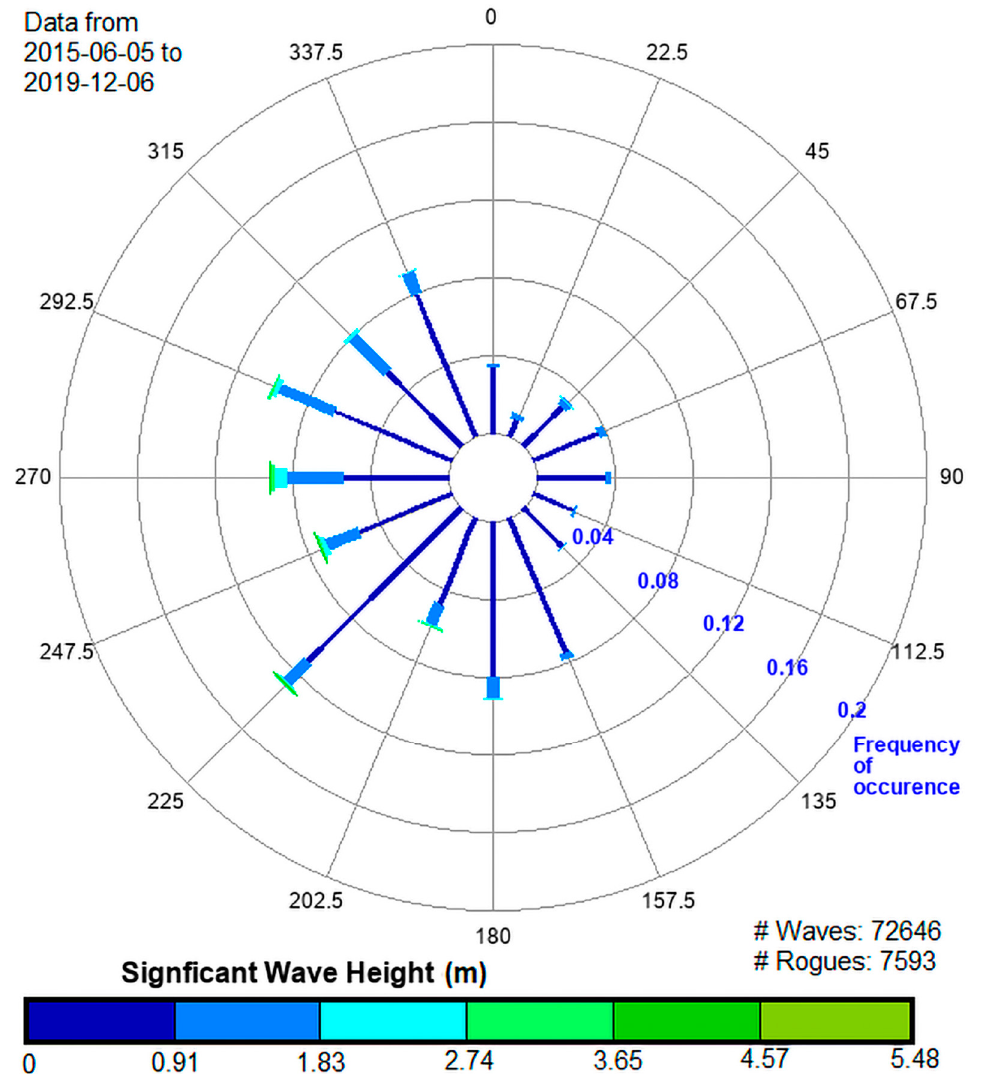
Figure 4. A wave rose graph showing the frequency of occurrence and significant wave height (H s ) values (in meters) of individual waves coming from each direction bin. The bar width is proportional to the significant wave height. The wave direction shows a narrow spread from south to northwest. Source: Scripps Coastal Data Information Program (CDIP; http://cdip.ucsd.edu/themes/cdip?pb=1&u2=s:214:st:1&d2=p9 accessed on 15 April 2021).